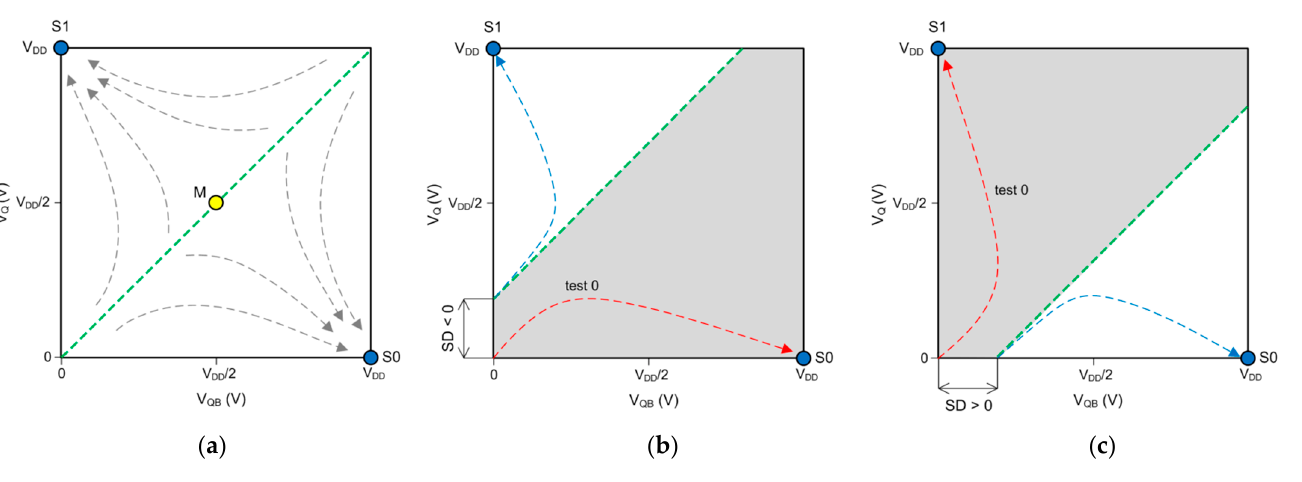
Figure 4. State space diagrams for: ( a ) a perfectly symmetric cell; ( b ) a cell biased towards logic ‘0’ state; ( c ) a cell biased towards logic ‘1’ state. Separatrix is represented in green. Each red trajectory (test 0) represents the initial transient analysis used to determine the cell bias, and each blue line is the trajectory with less SD voltage shift that makes the cell start up to the opposite state determined with test 0.